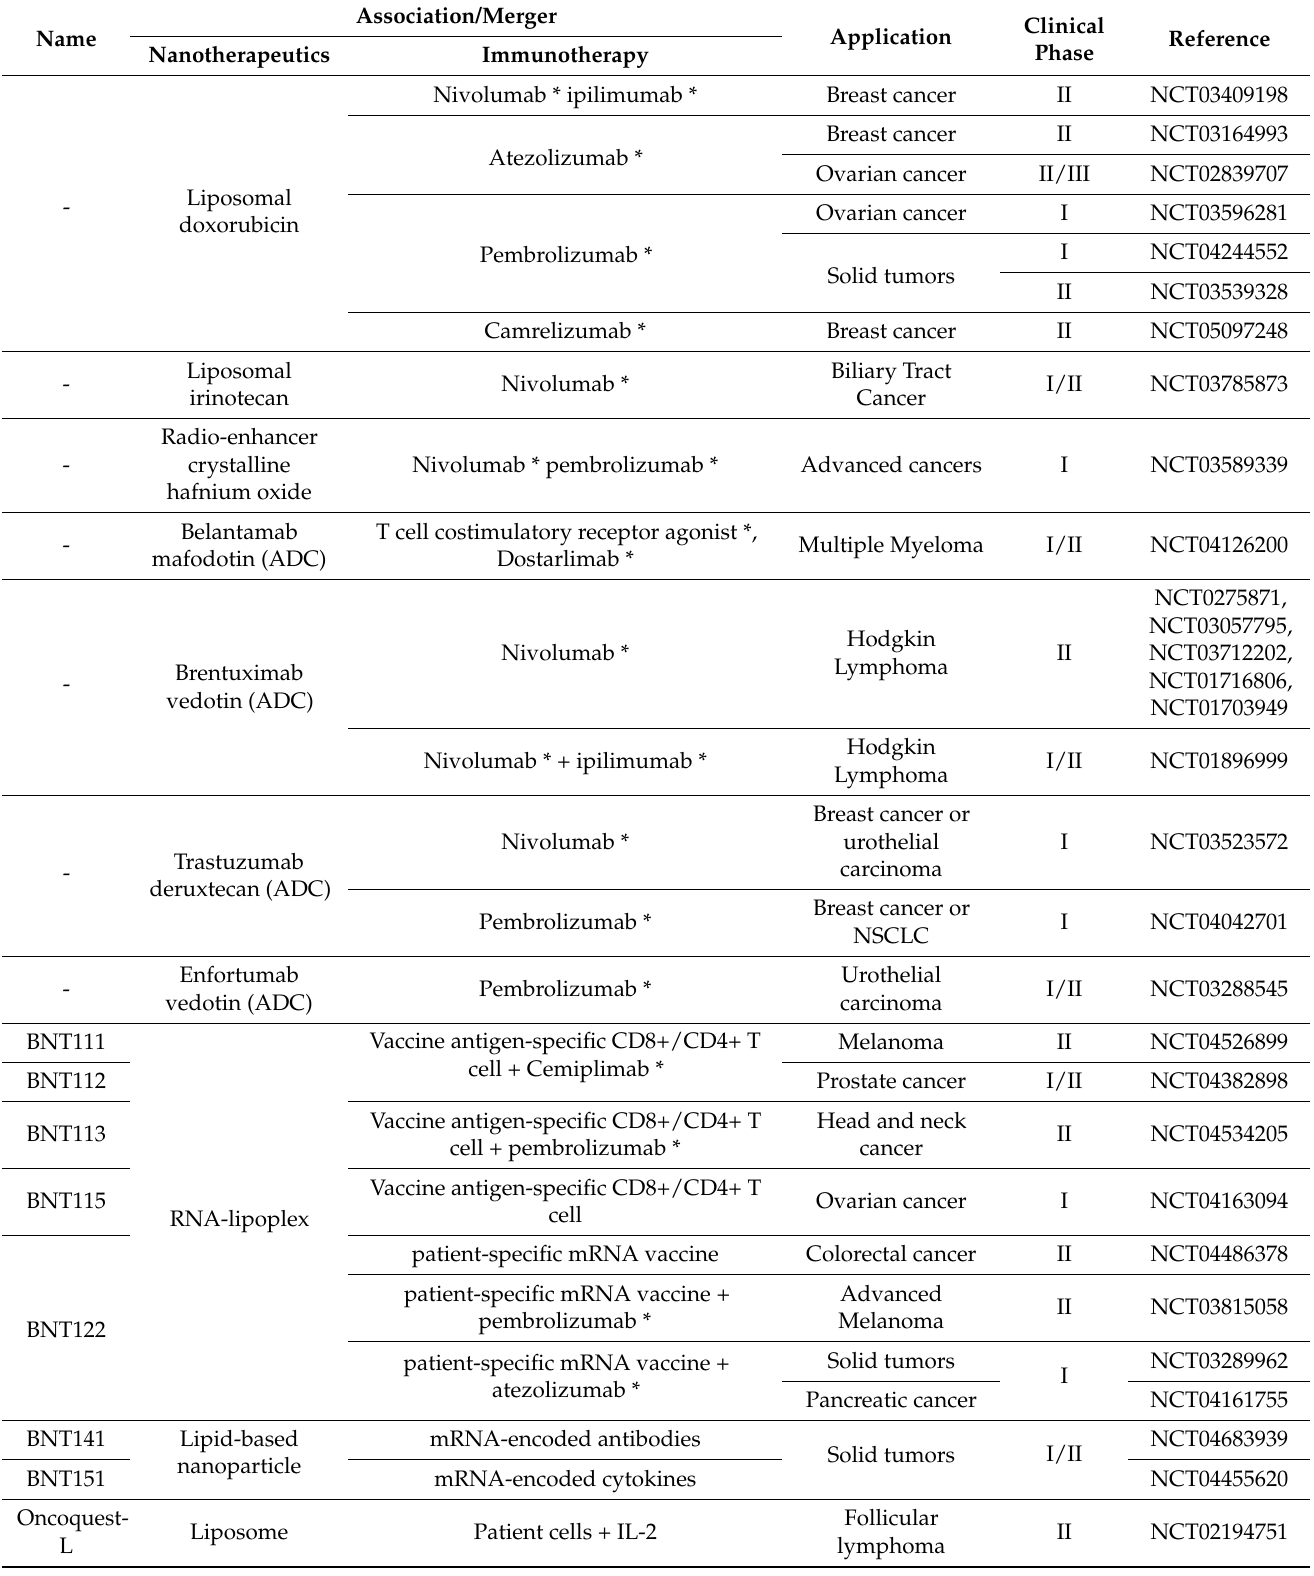
Table 6. Summary of the most relevant clinical trials in oncology evaluating nano-immunotherapies’ potential (excluding nanoparticles engrafted with antibodies, and nab-paclitaxel association). * Im- munotherapies are given as a different entity, meaning that the immunotherapy is not merged within the nanotherapeutics (i.e., neither linked nor